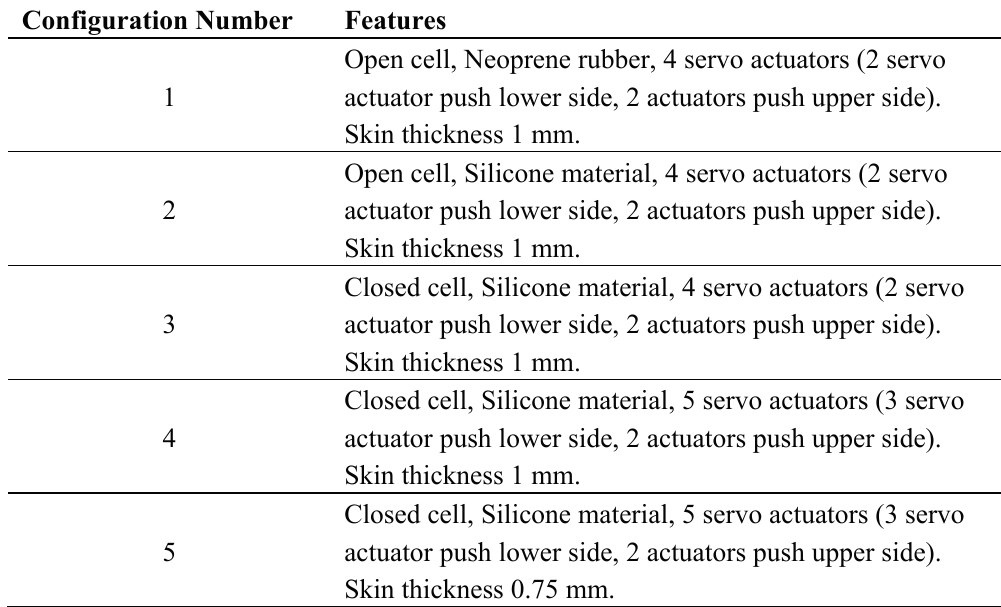
Table 6. Configurations and respective characteristics of different